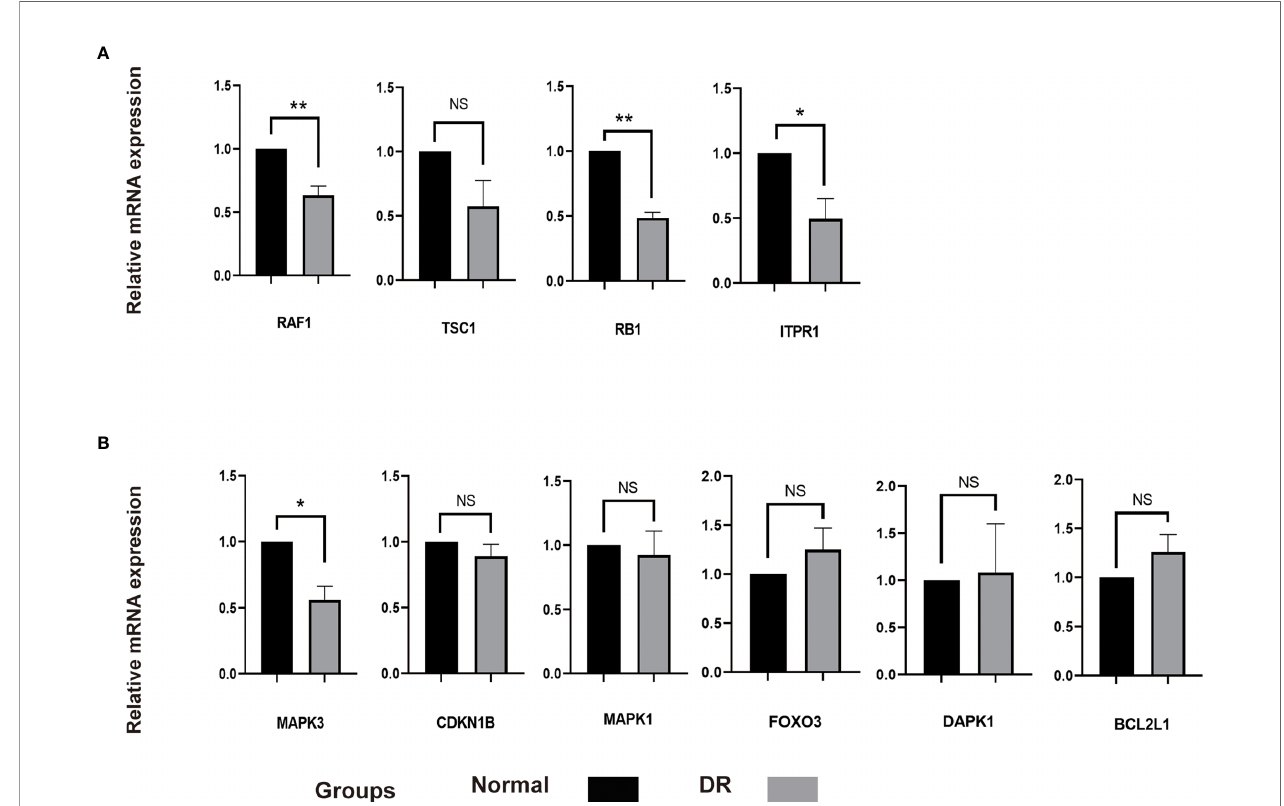
FIGURE 8 | The mRNA level of 10 hub genes were measured in ARPE-19 cells. (A) , The mRNA level of RAF1, TSC1, RB1 and ITPR1 were evaluated in cell samples by qRT-PCR. (B) , The mRNA level of MAPK3, CDKN1B, MAPK1, FOXO3, DAPK1 and BCL2L1 were measured in cell samples by qRT-PCR. P-values were calculated using a two-sided unpaired Student ’ s t-test. *P < 0.05; **P < 0.01; ns, non-signi fi cant. ARPE-19, retinal pigment epithelial cell line; qRT-PCR, quantitative real-time polymerase chain reaction.